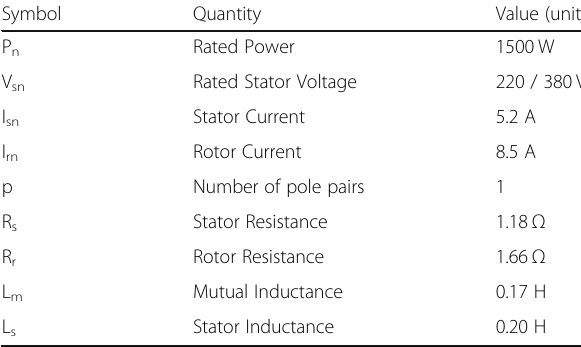
Table 1 DFIG A4222